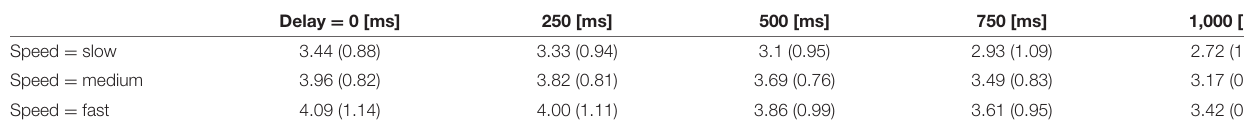
TABLE 7 | Average (standard deviation) of sense of agency rating scores.